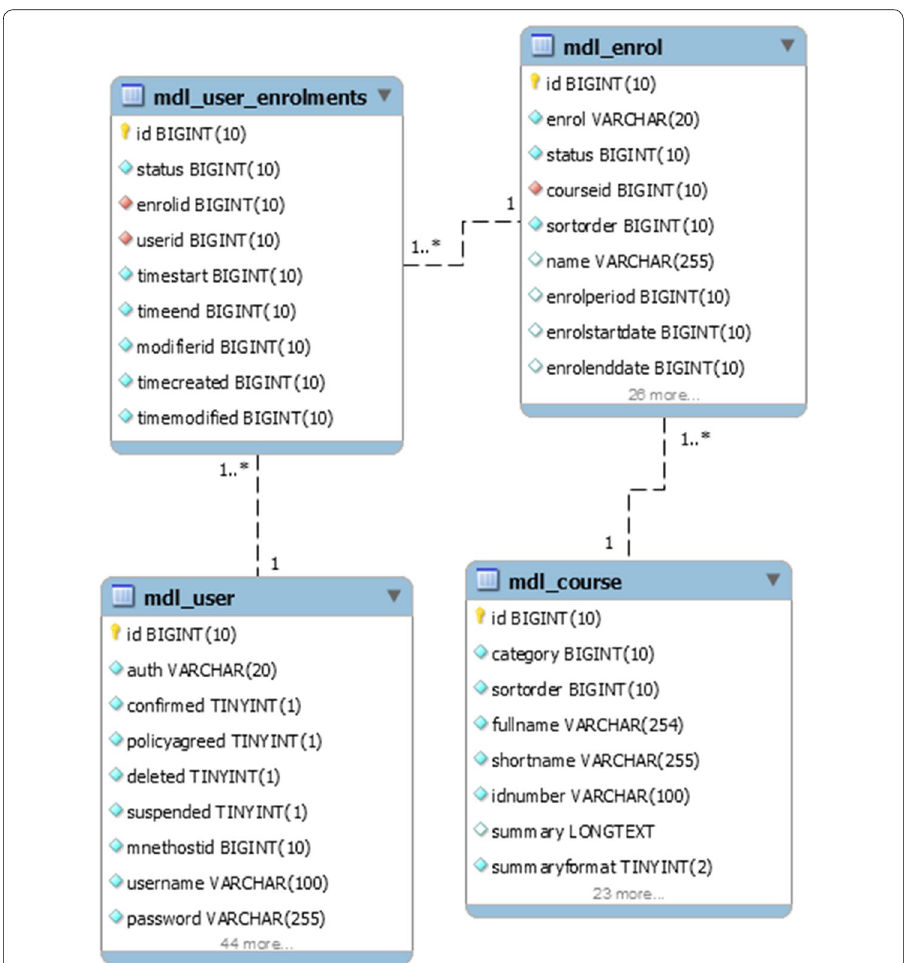
Fig. 4 Class diagram of ESTenLigne database: It shows relationship between the four tables used to collect appropriate data of historical learners’ enrolments from Moodle